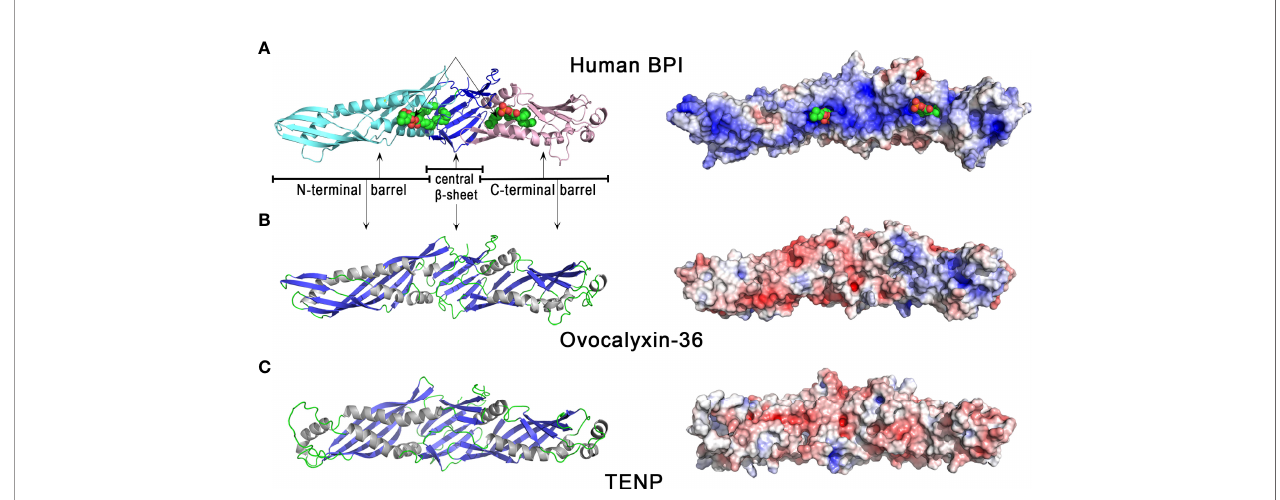
FIGURE 3 | 3D structures of human BPI and chicken eggshell BPI/LBP/PLUNC proteins, ovocalyxin-36 and TENP. 3D structure of human BPI (A) , chicken ovocalyxin-36 (B) , and chicken TENP (C) . The left panels correspond to the cartoon representation of 3D structure while the right panels show the color-coded electrostatic potential molecular surface. Color scheme ranges from red (negatively charged regions) to deep blue (positively charged regions). The fi gure was prepared using Pymol software (48) and APBS (Adaptive Poisson-Boltzmann Solver) plugin (49) for electrostatic calculations using atomic coordinates of 1BP1 PDB fi le (www.rcsb.org) for human BPI. The structure of ovocalyxin-36 was predicted by homology modeling using SwissModel server (swissmodel.expasy.org) and human BPI as a template. The 3D structure of TENP was modeled using the AlphaFold algorithm and was retrieved in the AlphaFold protein structure database under accession number AF-O42273-F1 (72,